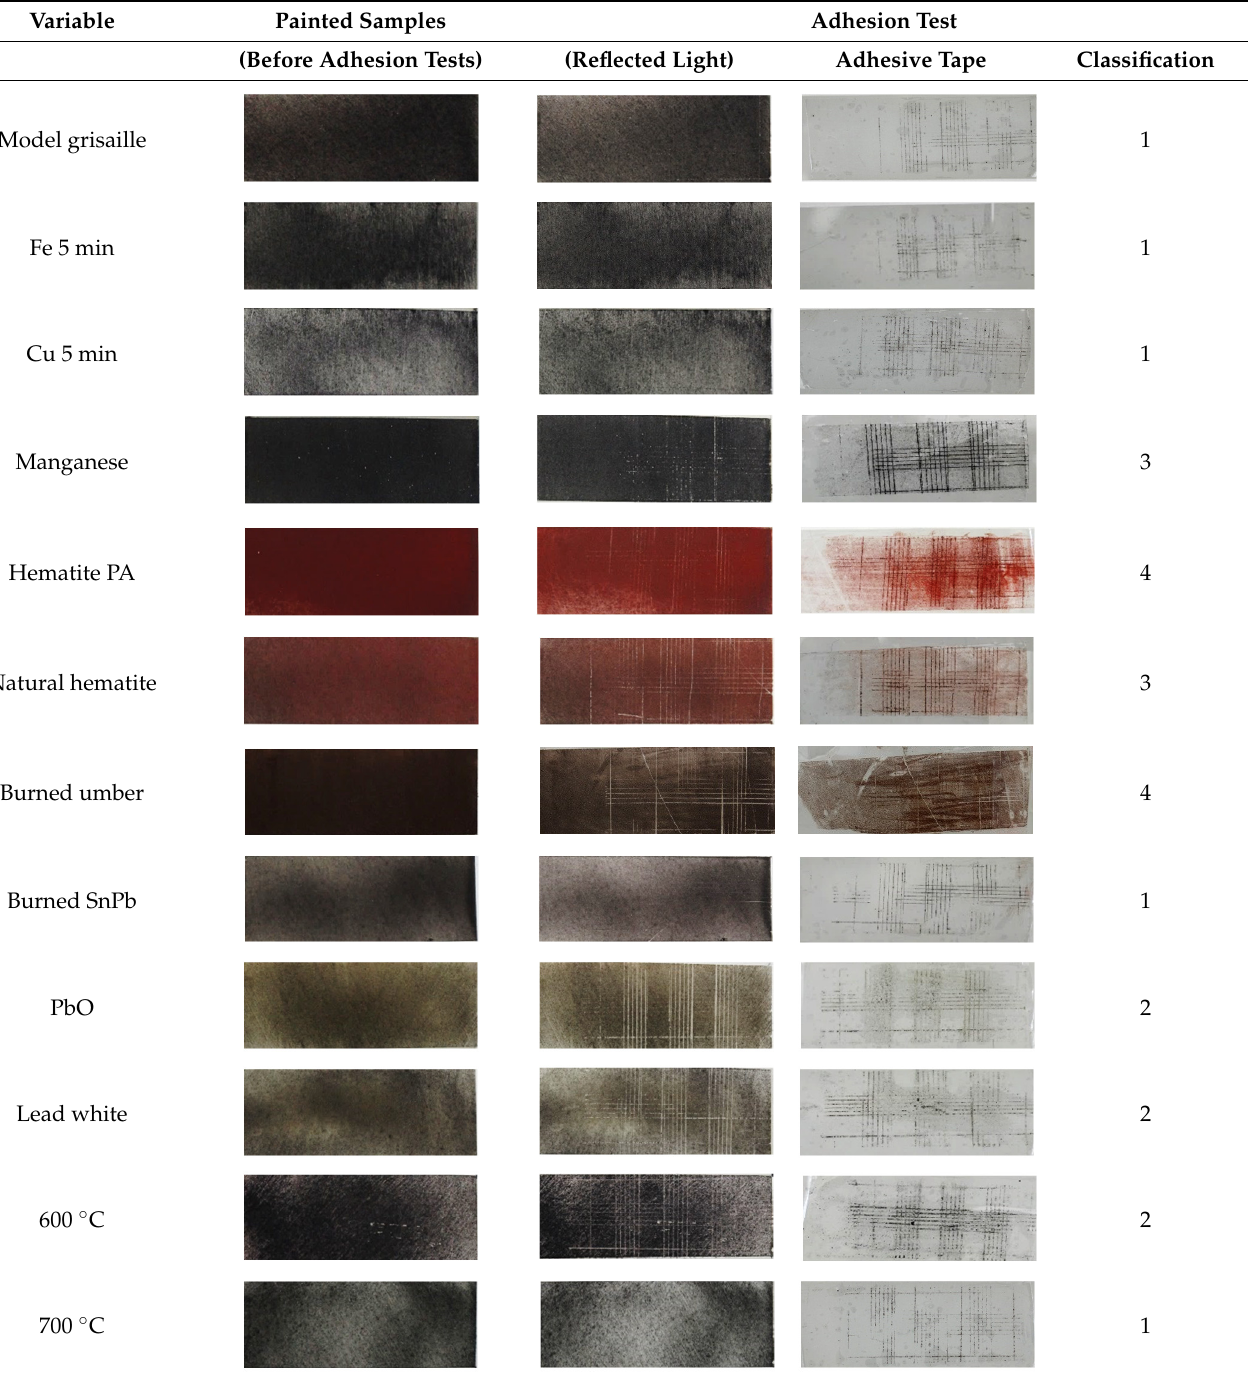
Table 6. Results from the adhesion test.